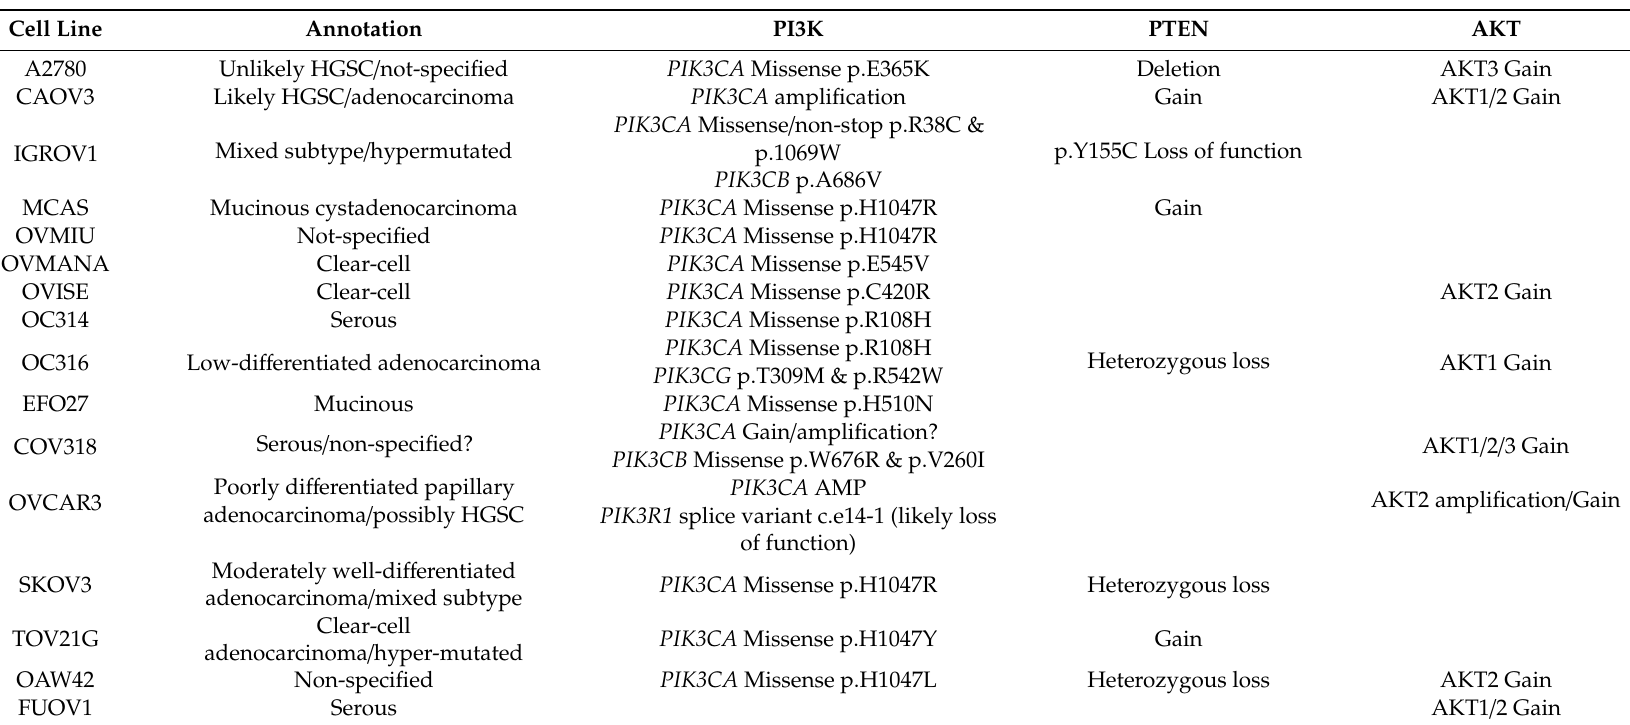
Table 1. Summary of mutations in the PI3K-AKT pathway in 13 OvCa cell lines collected from Cancer Cell Line Encyclopedia (CCLE), https: // oncokb.org, and